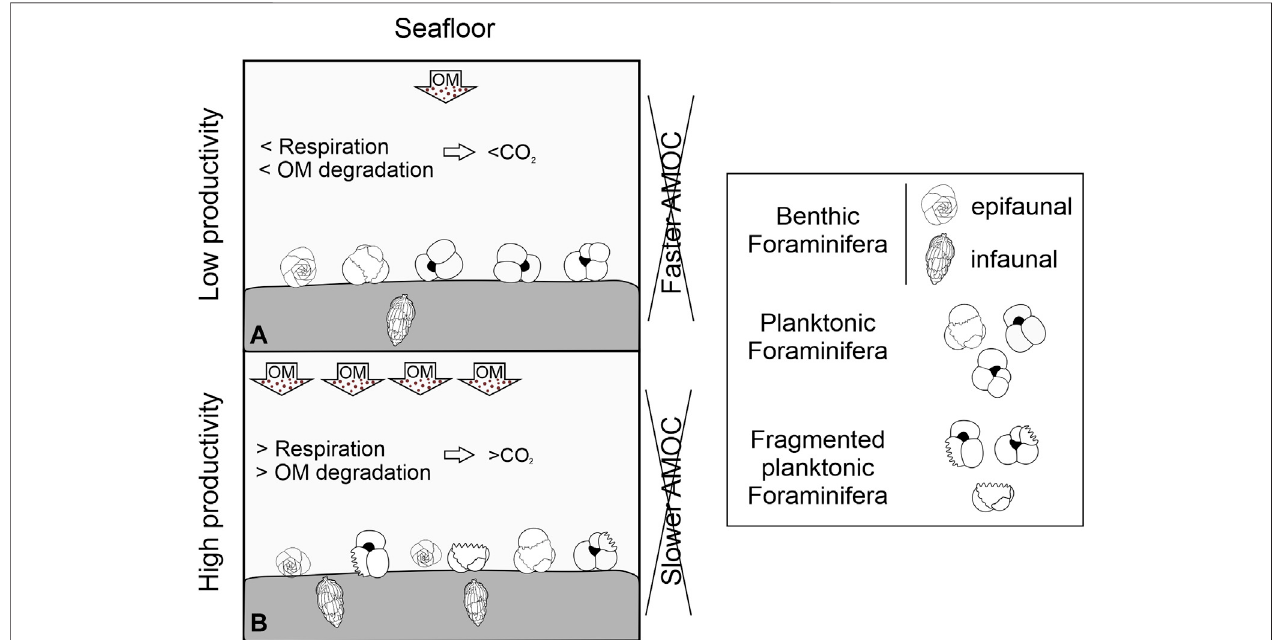
FIGURE4 | Schematic representation oftwopossible end-member scenariosaffectingcarbonate dissolution on deep-water assemblages ofsedimentcore SAT- 048A (South Atlantic). The paleoceanographic changes could be triggered by: (A) Low organic matter (OM) inputs to the sea fl oor, which results in lower benthic abundances and better preservation of CaCO 3 , or (B) high OM input that increases benthic abundances and CO 2 concentrations, decreases the seawater pH, and dissolves the planktonic Foraminifera tests (fragmentation on benthic Foraminifera was not assessed).